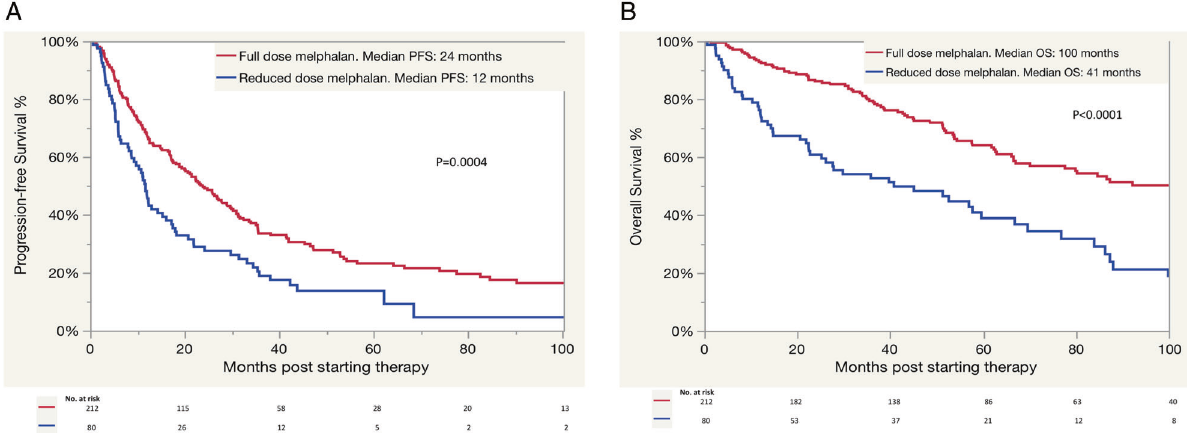
Fig. 3 Survival according to the melphalan dose received at diagnosis. PFS ( A ) and OS ( B ). PFS progression-free survival, OS overall